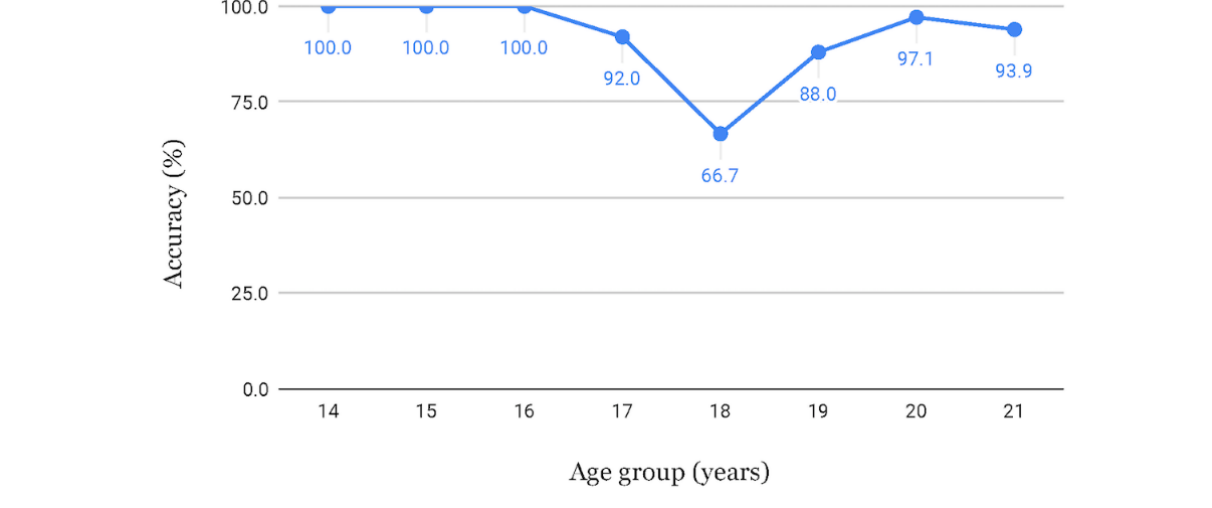
Figure 10. Accuracies for minor versus adult classification of male subjects, using threshold to increase accuracy for minors.